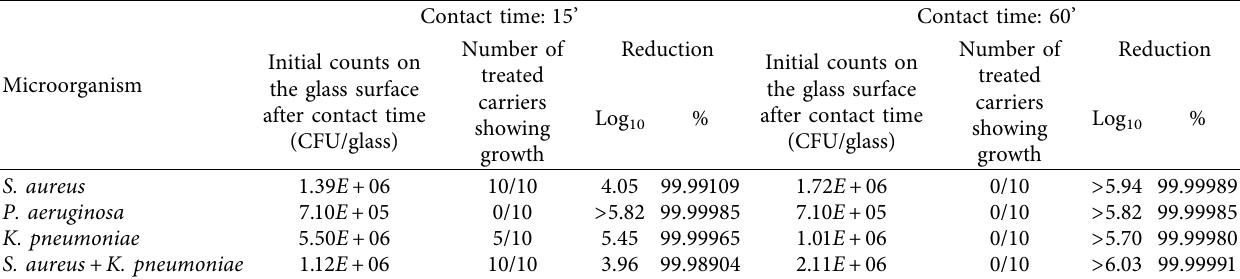
10 reduction and percentage after the action of Fitostimoline